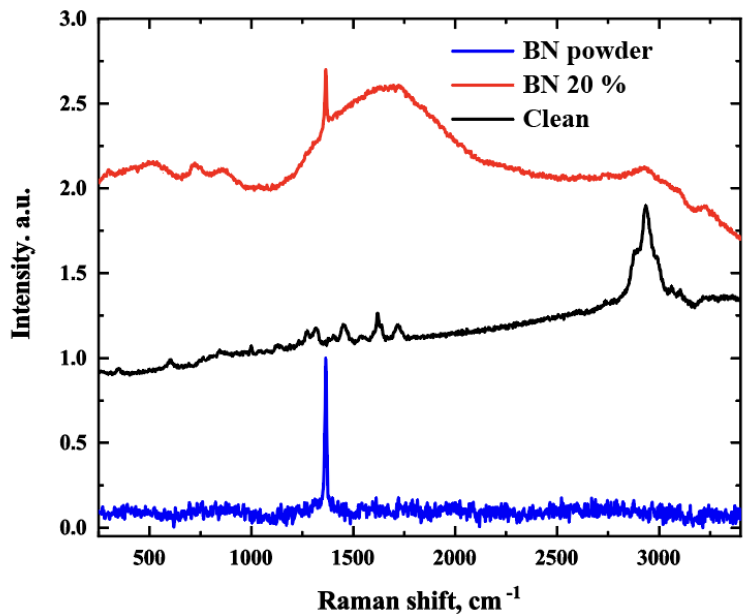
Figure 2. Raman spectra of BN powder, clean polymer, and 20% BN – filled polymer.